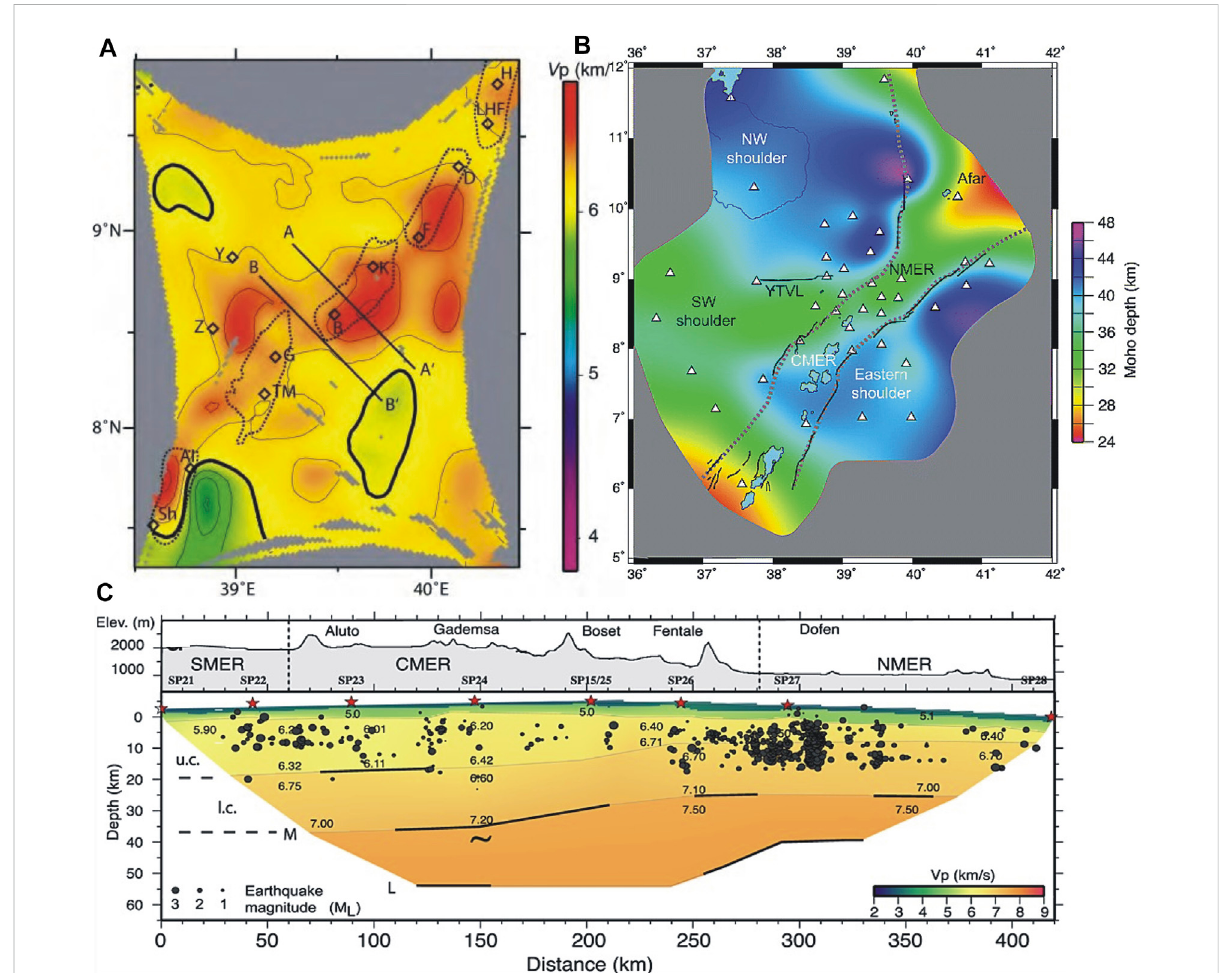
FIGURE 2 Previous seismic studies in the MER. (A) horizontal slice of VP at 10 km underlying TMSs (Dashed lines) and eruptive centers (Diamonds where Sh, Shala; Al, Aluto; TM, Tulu Moye; G, Gedemsa; B, Boseti; K, Kone; F, Fentale; D, Dofan; LHF, Liyado-Hayk fi eld; H, Hertale), A-A ′ and B-B ′ are velocity pro fi les (Keranen et al., 2004). (B) Moho depth over the MER and adjacent plateaus with the dashed gray lines show the rift outlines, solid black lines are the rift border faults (Keranen et al., 2009) and the white triangles represent seismic stations. (C) Topographic pro fi le (top) and p wave velocity model (bottom): Labels, u. c., upper crust; l. c., lower crust; M, Mohorovic discontinuity; and L, mid-Lithospheric re fl ector. Stars, shot point location and black dots, Earthquake hypocenters (Maguire et al.,